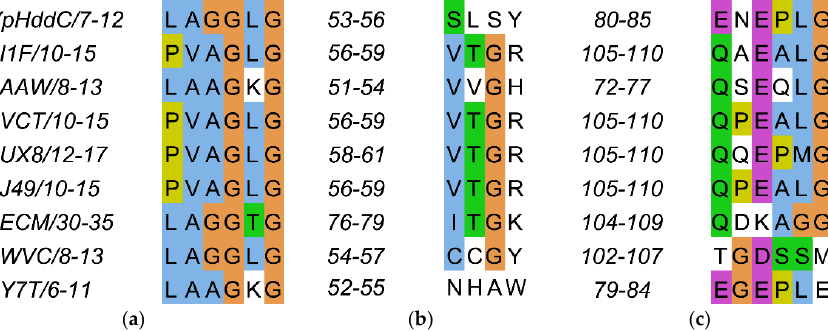
Figure 4. The sequence alignment of the three loops comprising the nucleotide ‐ binding pocket of Yp HddC. ( a ) Loop 2 (L2); ( b ) Loop 4 (L4); and ( c ) Loop 6 (L6) are depicted in multiple sequence alignment using Jalview [12]. The top eight closest of Yp HddC of which the protein structures have been deposited in the Protein Data Bank (PDB) (PDB ID: 5XHW) were selected and aligned. The sequence numbers of the loops are displayed on the left side of each sequence. Blue , hydrophobic; Magenta , negative charge; Green , polar; Orange , glycines; Yellow , prolines; White , unconserved. They are contributing to building the canonical signature motif, GXGXR. Ala8, Gly9, and Gly10 experience an induced ‐ fit conformational change when they interact with GMPPN in the crystal structure. In detail, an oxyanion hole ‐ like conformation was induced by the three rearranged backbone nitrogen atoms. Consequently, the induced oxyanion hole attracts the O2 ′ oxygen atom of the ribose moiety of GMPPN (Figure 1c). The distances between the backbone amide groups of Ala8, Gly9, Gly10 and the O2 ′ oxygen atom are 4.16 Å, 3.41 Å, and 2.94 Å, respectively. In contrast, this oxyanion ‐ like architecture is not induced but already formed in the native crystal structure of MurU [13] or is absent in CMP ‐ 2 ‐ keto ‐ 3 ‐ deoxy ‐ manno ‐ octulsonic acid synthetase [14]. The residues on the loop L4 are Ser53, Leu54, Ser55 and Tyr56 (Figure 4b). In the majority of nucleotidylyltransferase, valine is the highly conserved residue at the corresponding position of Ser53 of Yp HddC. Interestingly, this serine residue of Yp HddC does not show meaningful interaction with the guanine base. Actually, the atomic positions of Ser53 and Leu54 are unaffected after the GMPPN binding (Figure 1c). Meanwhile, the hydroxyl group of Ser55 is rotated 180° to avoid the electrostatic repulsion caused by the conformational change of the backbone carbonyl group of Gly9 during the GMPPN binding. Consequently, Ser55 lies almost at the outlier of the Ramachandran plot. This kind of unusual phenomenon is not observed in other uridylyltransferases. The residues on the loop L6 are Glu80, Asn81, Glu82, Pro83, Leu84, and Gly85 (Figure 4c). Of these, Asn81 and Glu82 locate outside the GTP binding pocket. The overall positional shift of the L6 loop during the GTP binding seemed limited. It means that the binding of the base portion of GTP follows a lock ‐ and ‐ key mechanism contrast to the triphosphate portion requiring an induced ‐ fit docking. The same phenomenon is also observed in the crystal structures of α‐ D ‐ glucose ‐ 1 ‐ phosphate cytidylyltransferase from Salmonella typhi ( St RfbF) and Pp MurU of which the native and pyrimidine ‐ bound forms have been published. The volume of each cavity for bases is around 290 Å 3 regardless of bases when calculated with the MOLCAD module implemented in SYBYL ‐ X 2.1.1. [15] Therefore, the base binding pockets of these enzymes are almost preformed and the sizes of cavities do not seem to have a role to distinguish between purines and pyrimidines. L6 contains Glu80 which is a key residue to interact with GMPPN. Two oxygens of the Glu80, O ε 1, and O ε 2, make interactions with N2 and N1 atoms of guanine with the distances of 2.84 Å and 2.79 Å, respectively (Figure 1c). Previously, the critical role of Glu80 was predicted by multiple sequence alignment and anticipated by a manual docking of GTP with a native Yp HddC [8]. Glu80 is found in a unique motif EXEPLGTGGA among approximately five thousand HddC homologs. Therefore, the formation of hydrogen bonds between two oxygens of Glu80 and two nitrogen atoms of GMPPN was suggested to be a major driving force to select and interact with the guanine ring of GMPPN. Due to the binding of the citrate molecule, the spatial orientation of the pyrophosphate of